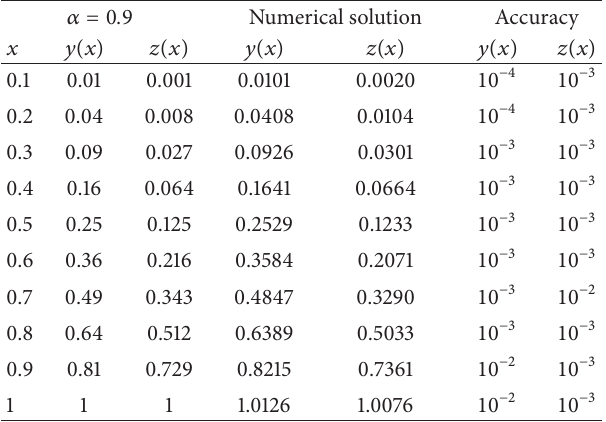
Figure 10: The graphics of the function Cos 𝛼,1−𝛼 (𝑥) . Table 6: Exact solution, approximate solution, and accuracy for Example 4 .